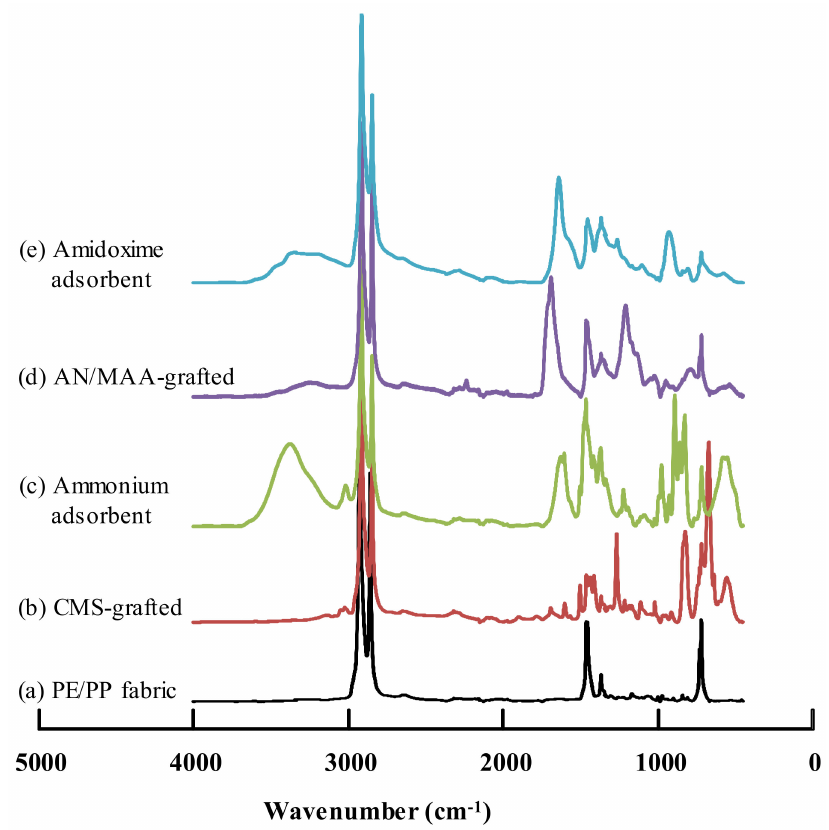
Figure 4. FTIR/ATR spectra for ( a ) the PE/PP nonwoven fabric; ( b ) the CMS-grafted fabric with a degree of grafting of 222%; ( c ) the relevant ammonium adsorbent; ( d ) the AN/MAA-grafted fabric with a degree of grafting of 119%; and ( e ) the relevant amidoxime